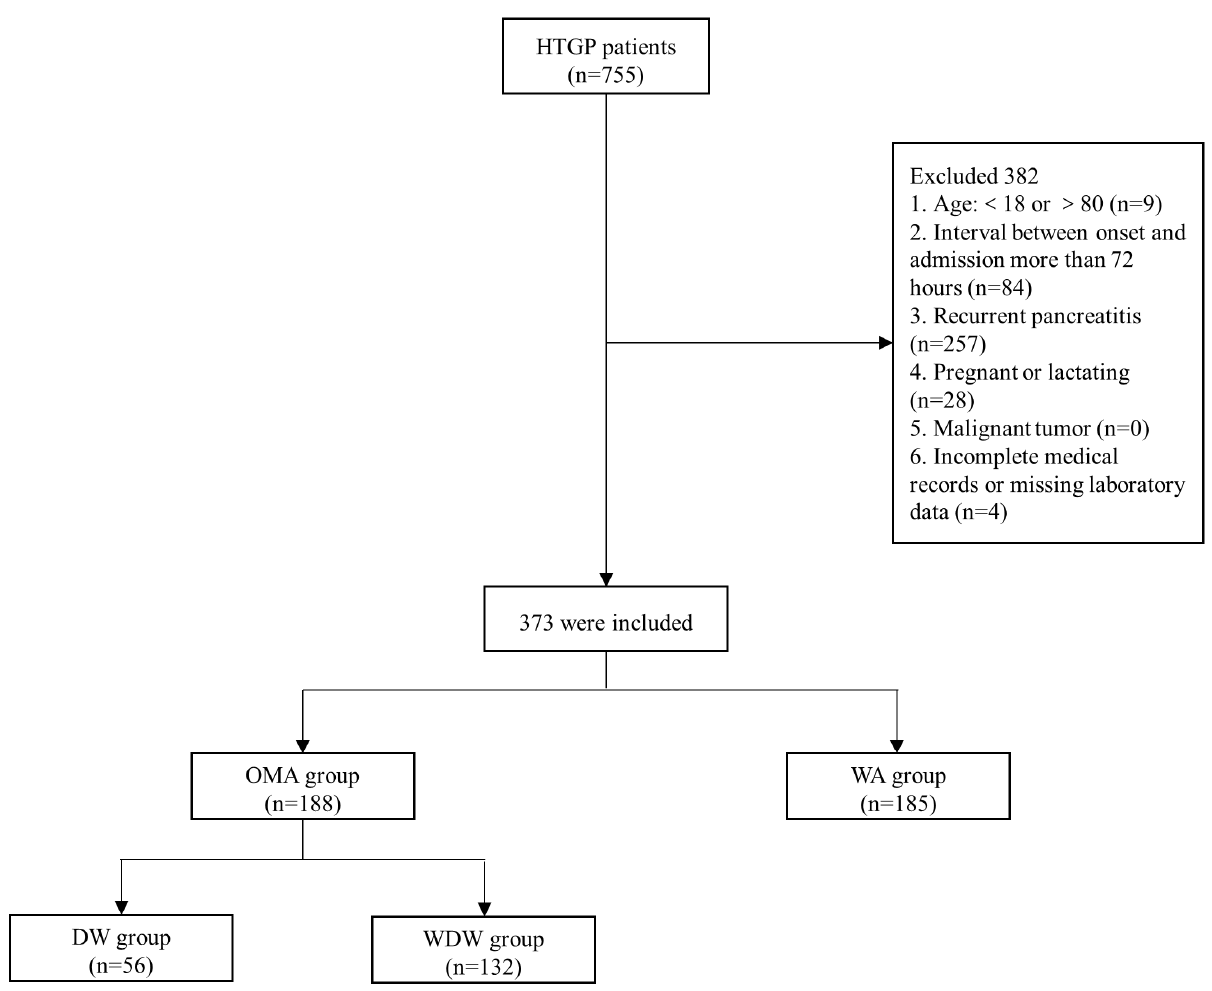
Figure 1. Flow of